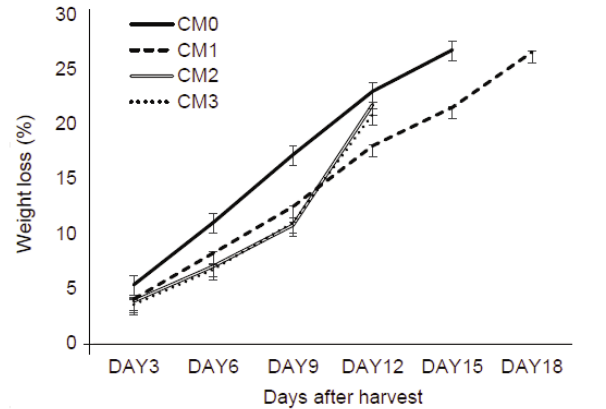
Fig. 1 ­ Effect of cactus mucilage coating on weight loss of bell pepper. Error bars indicate ±SE of the mean. CM0 is fruit coated with 0% cactus mucilage, CM1 is fruit coated with 1% cactus mucilage, CM2 is fruit coated with 2% cactus mucilage and CM3 is fruit coated with 3% cactus mucila­